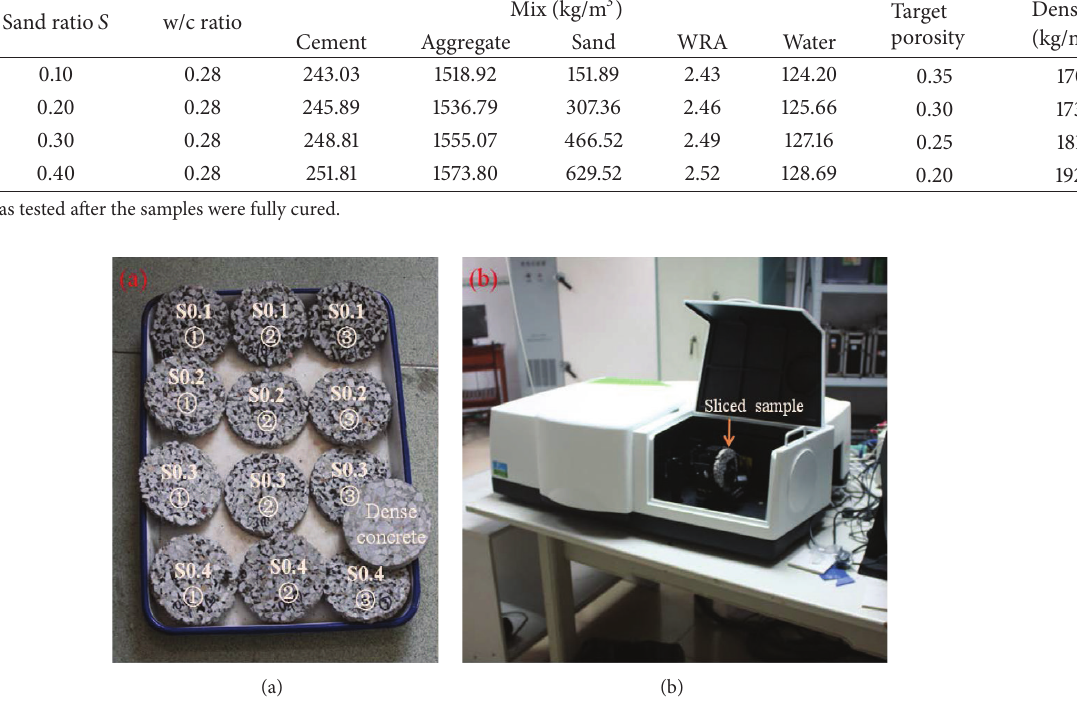
Figure 1: Sliced samples prepared for spectral reflectance test. (a) Pervious concrete slices. (b) Spectrophotometer Lambda 750.